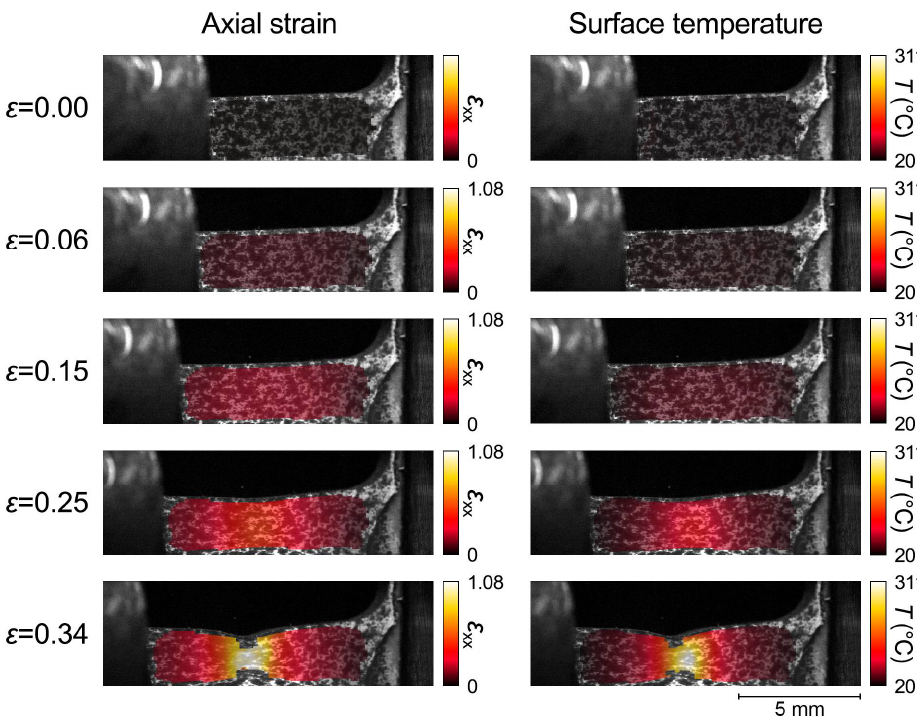
Figure 16. Full-field axial strain and surface temperature at different global engineering strains in a commercially pure titanium specimen loading in tension at room temperature and a strain rate of approximately 1000 s −1 .